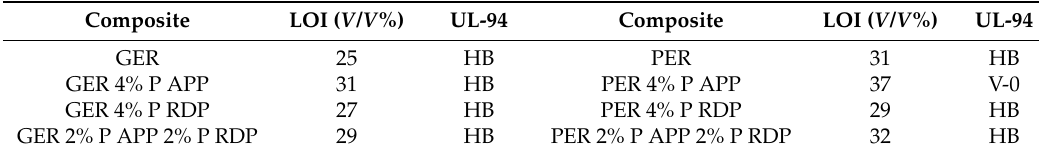
Table 6. LOI and UL-94 results of the reference and flame retarded GER and PER composites. Composite